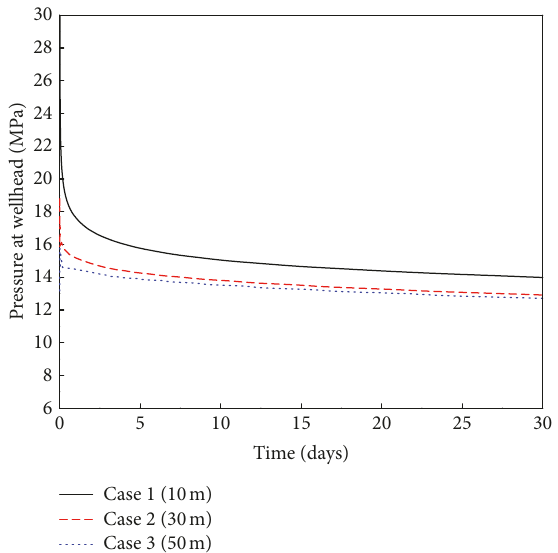
Figure 5: Change of pressure at the wellhead with time for the three cases.